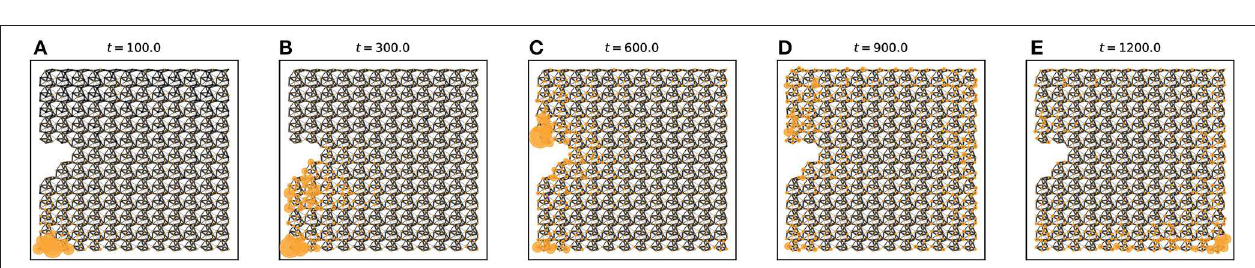
12 unit cells as shown in × 0 and t 150, a single node in the bottom left corner is = = 150, a localized excitation travels along the edge of the =